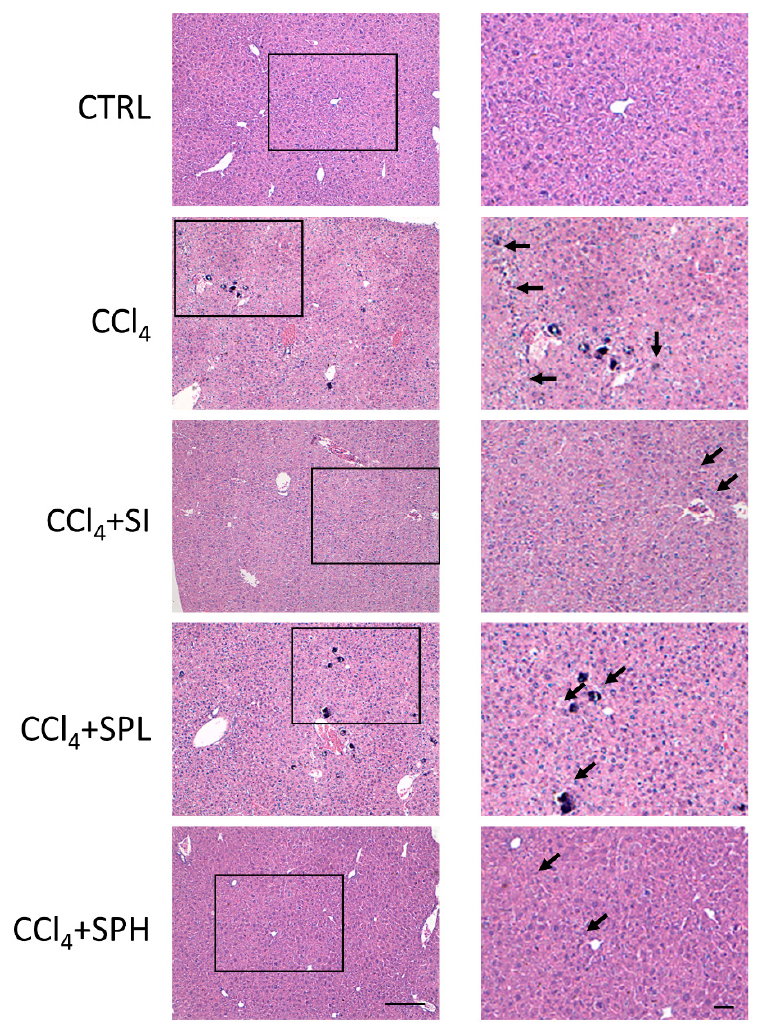
Figure 3. Effect of spore powder of A. camphorata on liver pathology in CCl 4 treated mice by H&E staining. Scale bar: 100 μ m. CTRL, control group; CCl 4 , carbon tetrachloride; SI, silymarin; SPL, low-dose treatment with spore powder of A. camphorata ; SPH, low-dose treatment with spore powder of A. camphorata .